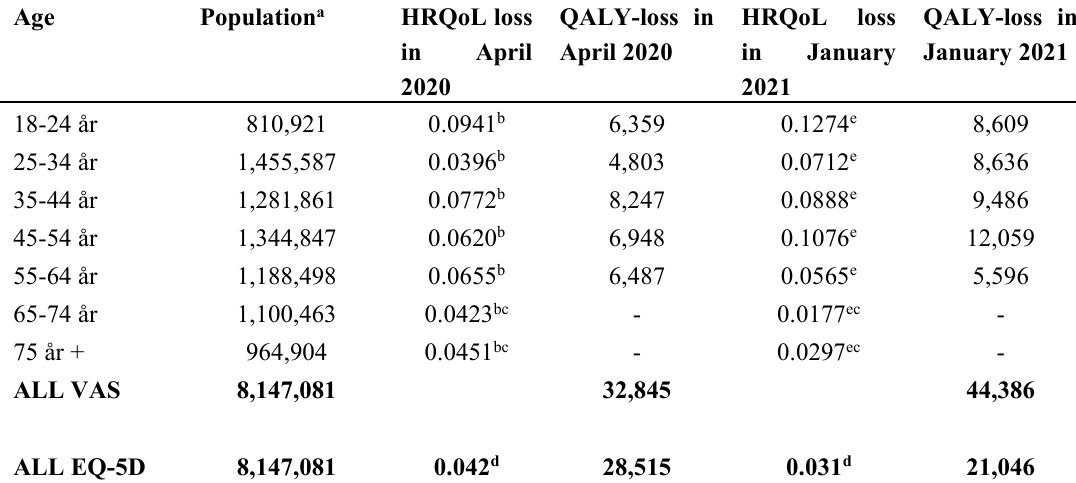
Table A2: QALY loss per month based on measurement in April 2020 and